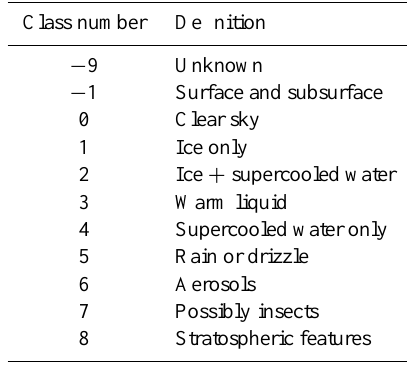
Table 1. DARDAR classes used in V1 version.